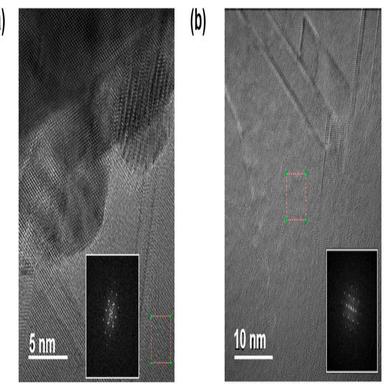
HRTEM bright field images taken along the zone axis (a) at the diamond/Ir interface; (b) inside the diamond film at 100 nm from the diamond/Ir interface. Inserts showed FFT extracted from the squared area indicated with red dotted lines. (For interpretation of the references to colour in this figure legend, the reader is referred to the web version of this article.)